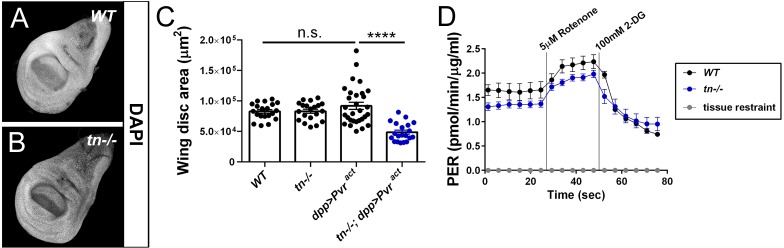
Wing disc size and glycolysis are not altered in tn-/-.(A,B) Isolated L3 wing discs are the same size when isolated from WT (A) or tn-/- (B) L3 larvae. (C) Scatter plot depicting the relative wing disc area in the indicated genotypes. N ≥ 20. (D) PER, a measure of the glycolytic rate, between WT and tn-/- wing discs appear similar. N = 10. Mean +/- SD. (****, p<0.001; *, p<0.05; n.s., not significant).